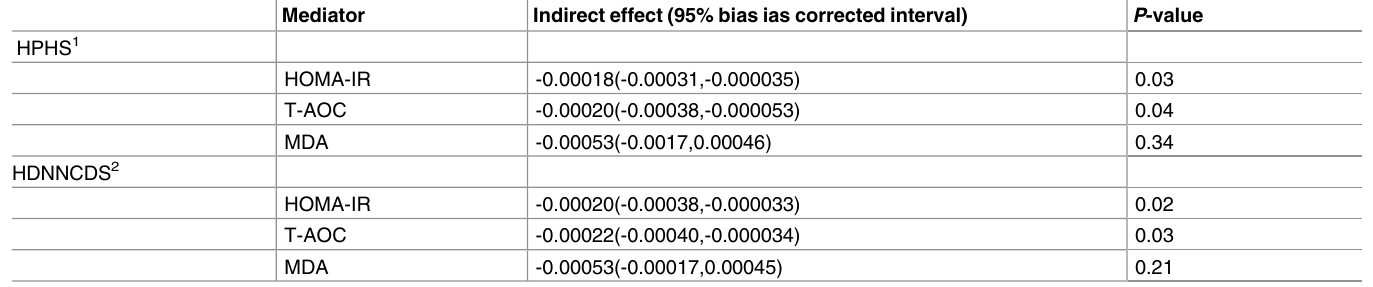
Table 4. Causal associations between per 10-mg increment of dietary vitamin C intake and type 2 diabetes in the Harbin People’s Health Study (HPHS, 2008–2012) and in the Harbin Cohort Study on Diet, Nutrition and Chronic Non-communicable